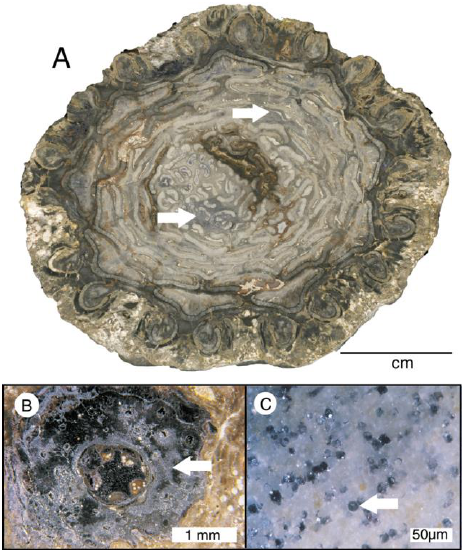
Figure 26. Silicified wood from Chemnitz, Germany, containing fluorite (marked with arrows). ( A ) Psaronius infarctus , with patchy fluorite; ( B ) climber Ankyropteris brongniartii. Fluorite is dark gray; ( C ) silicified gymnosperm wood with fluorite filling individual tracheids. Photos courtesy of Ronny Röβler, used with permission.